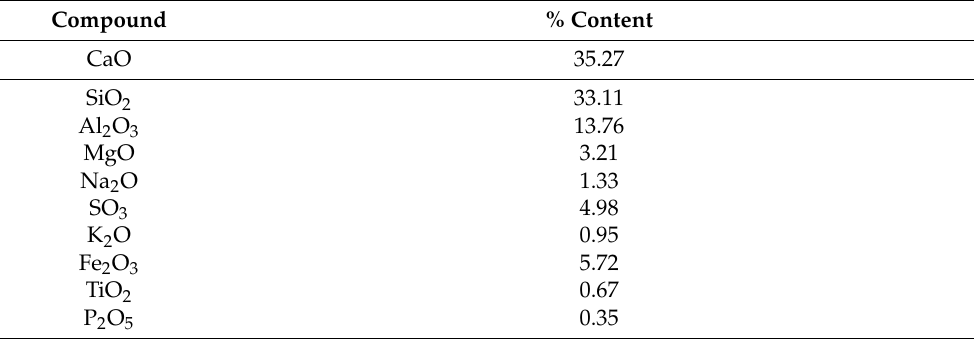
Table 2. Chemical analysis of the tested fly